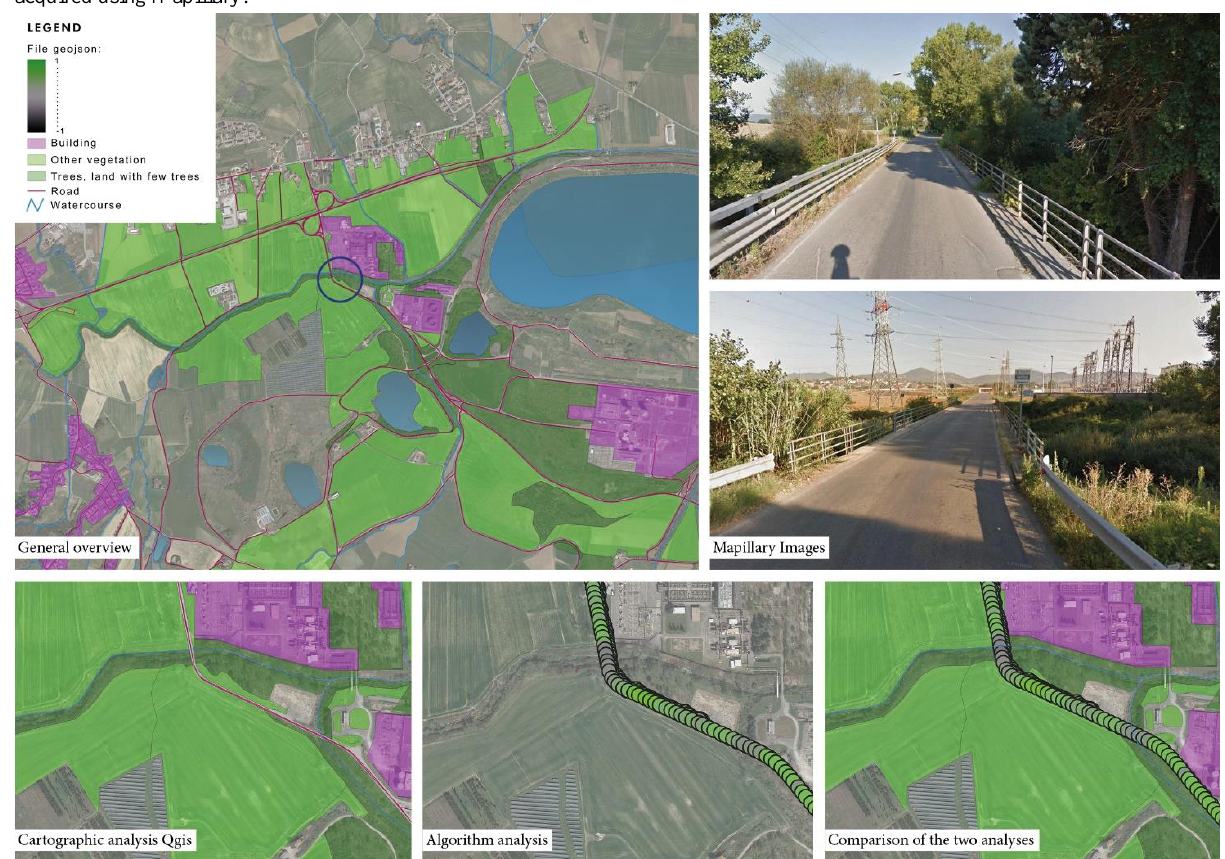
Figure 4 . Case study of